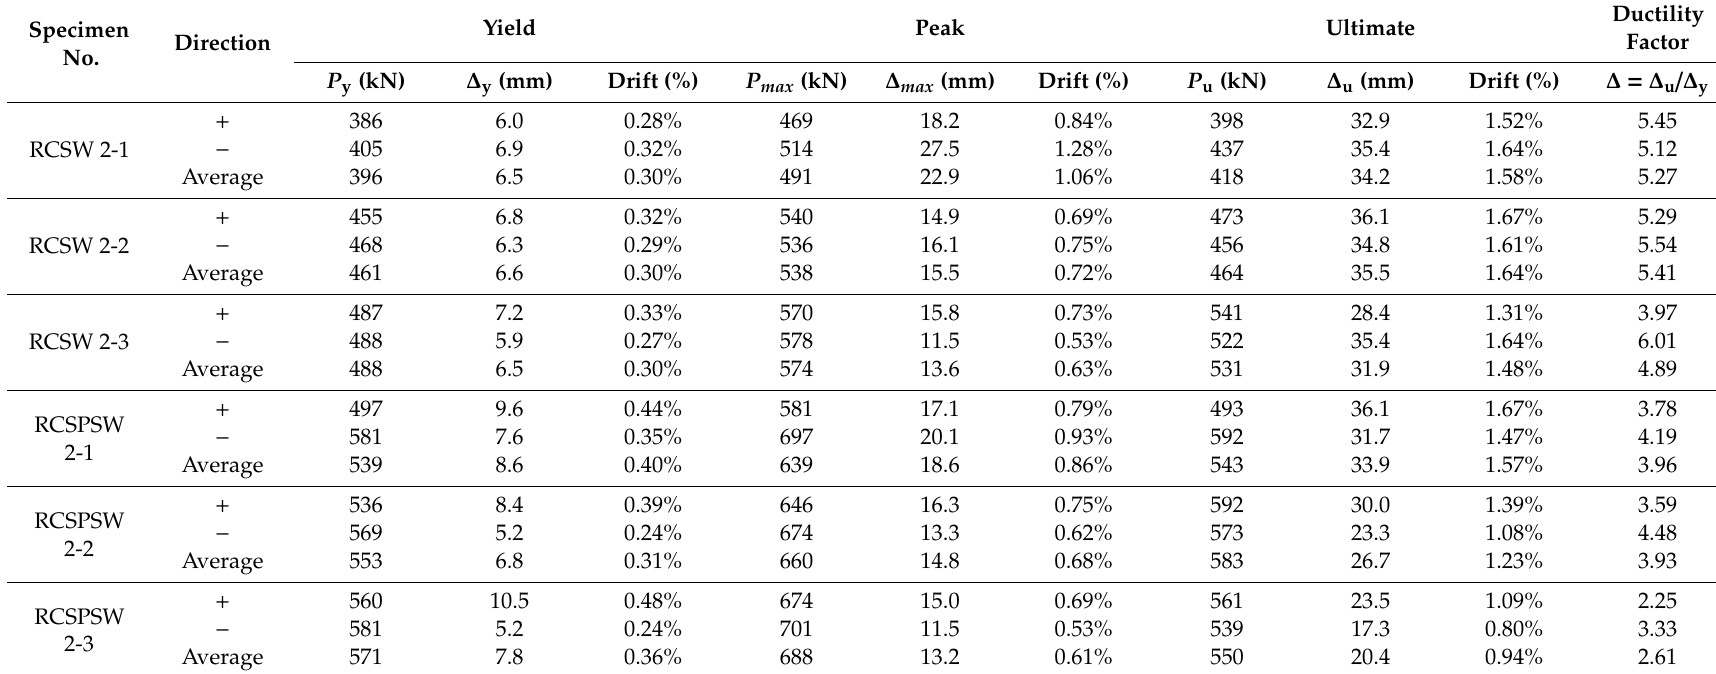
Table 4. Lateral Load and Displacement Capacity of Flexure